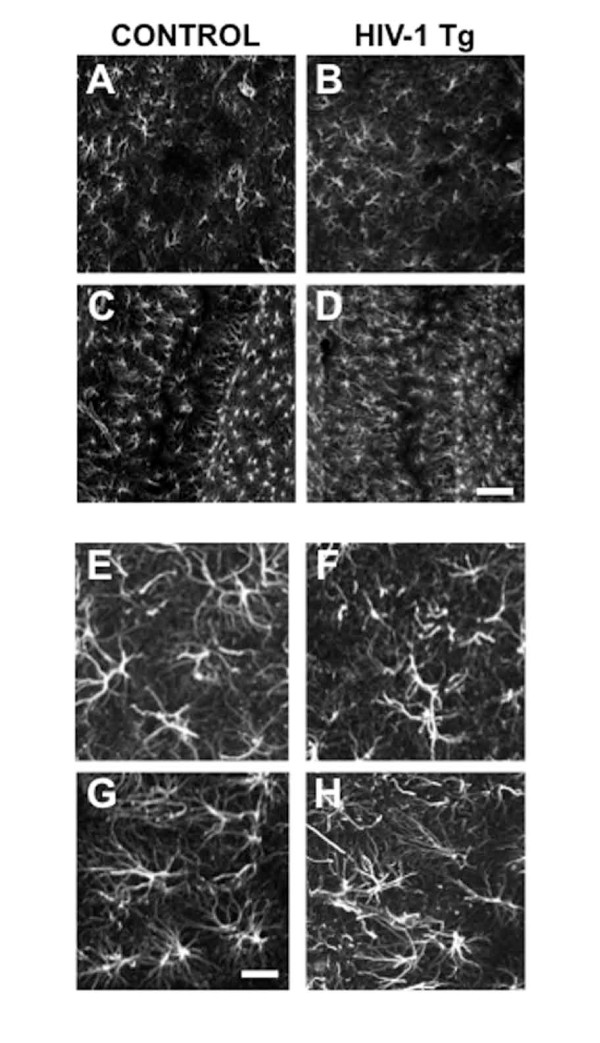
Representative immunofluorescence (gray scale) for GFAP+ astrocytes (white) in layers IV-V of somatosensory cortex of control (A) and HIV-1 Tg rats (B) and in the hippocampus dentate gyrus of control (C) and HIV-1 Tg rats (D) at 7 months of age. Scale bar = 50 microns. In 3-5 sections obtained from each of 4 animals per group, there was no evidence of astrocyte hypertrophy as represented in the higher magnification image of the astrocyte morphology in the (E, F) somatosensory cortex or (G, H) hippocampus. Images represent compiled z-stack images collected through a 50 micron section. Scale bar = 4 microns.